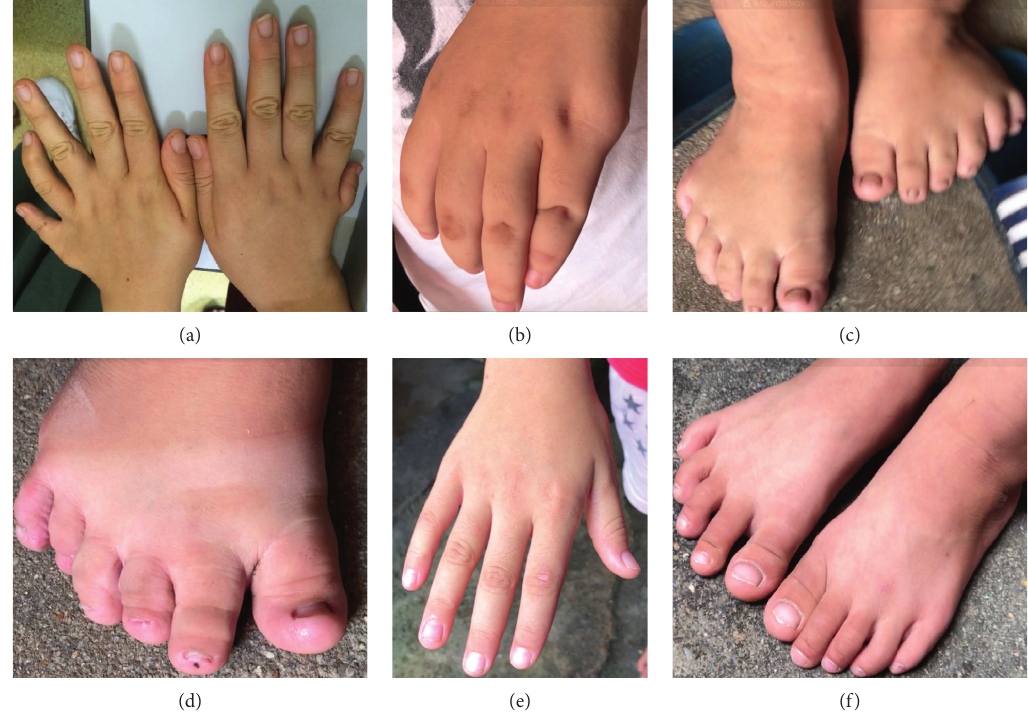
Figure 5: The hands and toes of affected and unaffected participants from family A and family B (a). Hands of IV:2 in family B showing polydactyly. (b) Hand of IV :2 in family A with surgically treated extra finger. (c) Brachydactyly and polydactyly (six toes) of IV: 2 in family A (d). Brachydactyly and polydactyly (six toes) of IV :10 in family A (e). (f) Normal hands and toes of IV: 6 in family